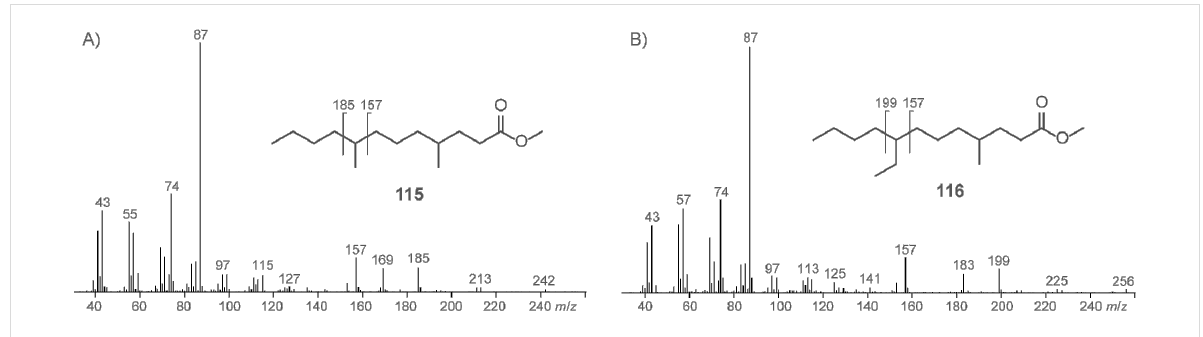
Figure 7: Mass spectra of tentatively identified methyl 4,8-dimethyldodecanoate ( 115 ) and methyl 8-ethyl-4-methyldodecanoate ( 116 ).